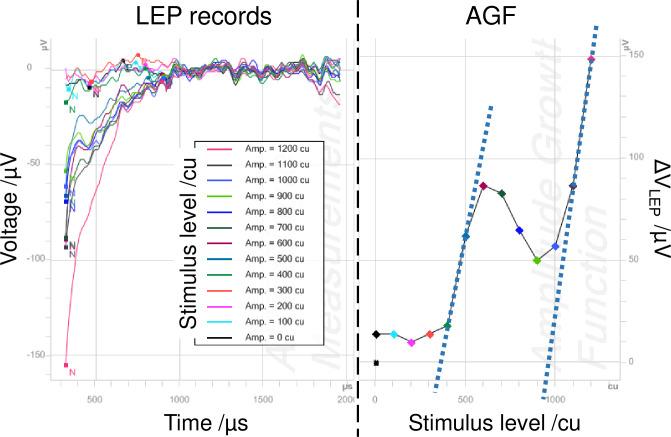
Example of a LEP measurement, which was not considered to contain a response.The AGF is ambiguous. Two linear regions (dotted lines) would lead to different LEP thresholds. Subject A-02, PD = 100 μs, stimulating electrode E02, recording electrode E01. See S2 Fig for raw responses.